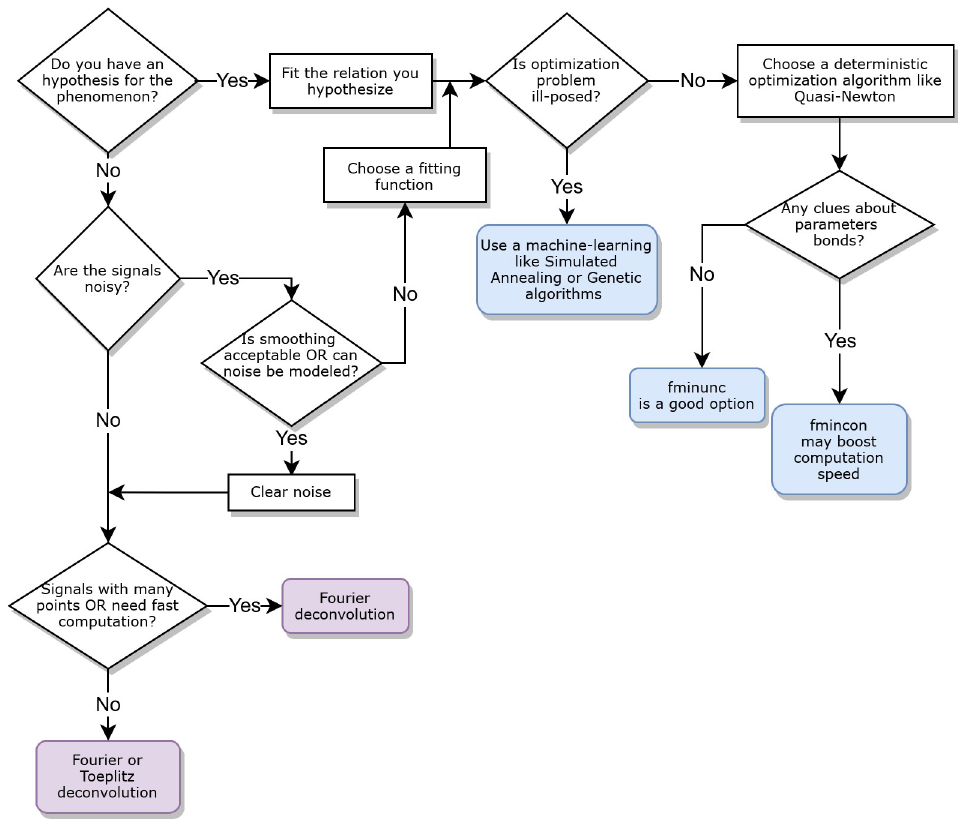
Fig 5. Decision tree to help choosing the most efficient method to compute a TF with Iliski, based on the data features.